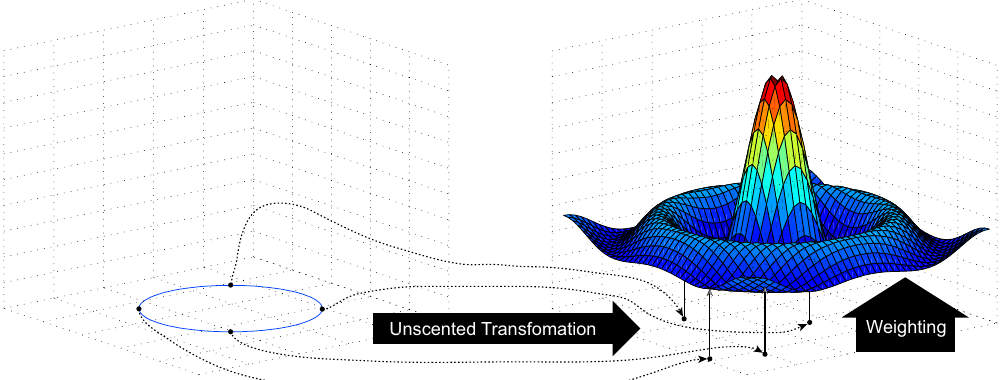
Figure 6. The principle of the SKPF